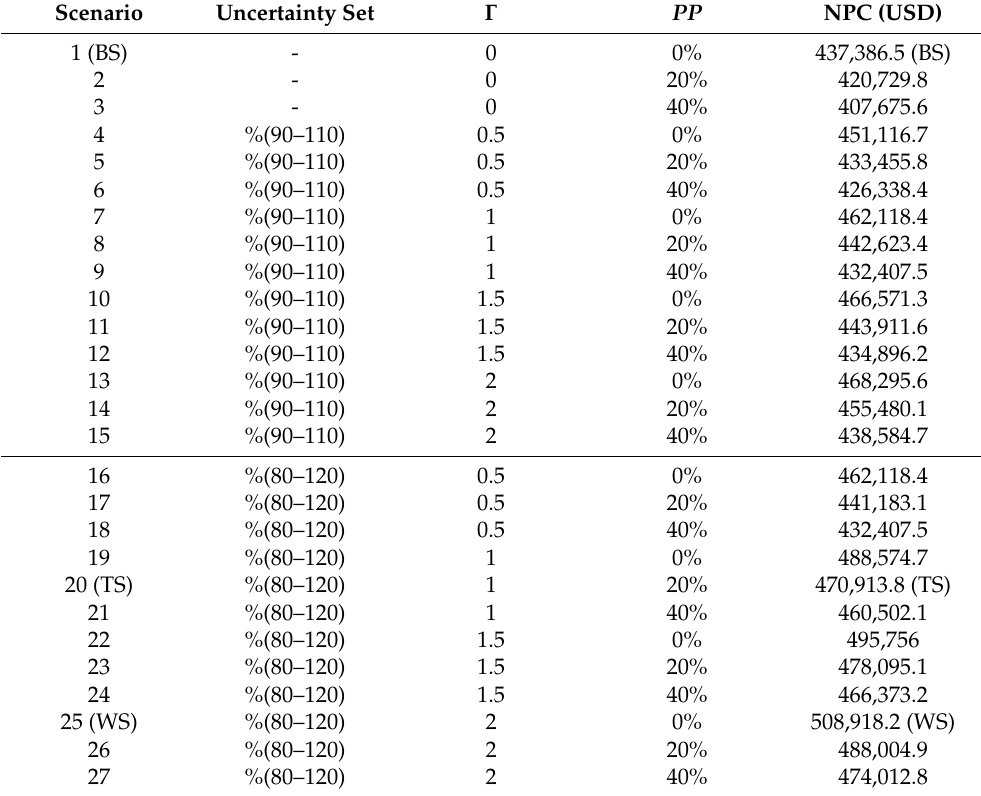
Table 3. Parameter values for sensitivity analysis.